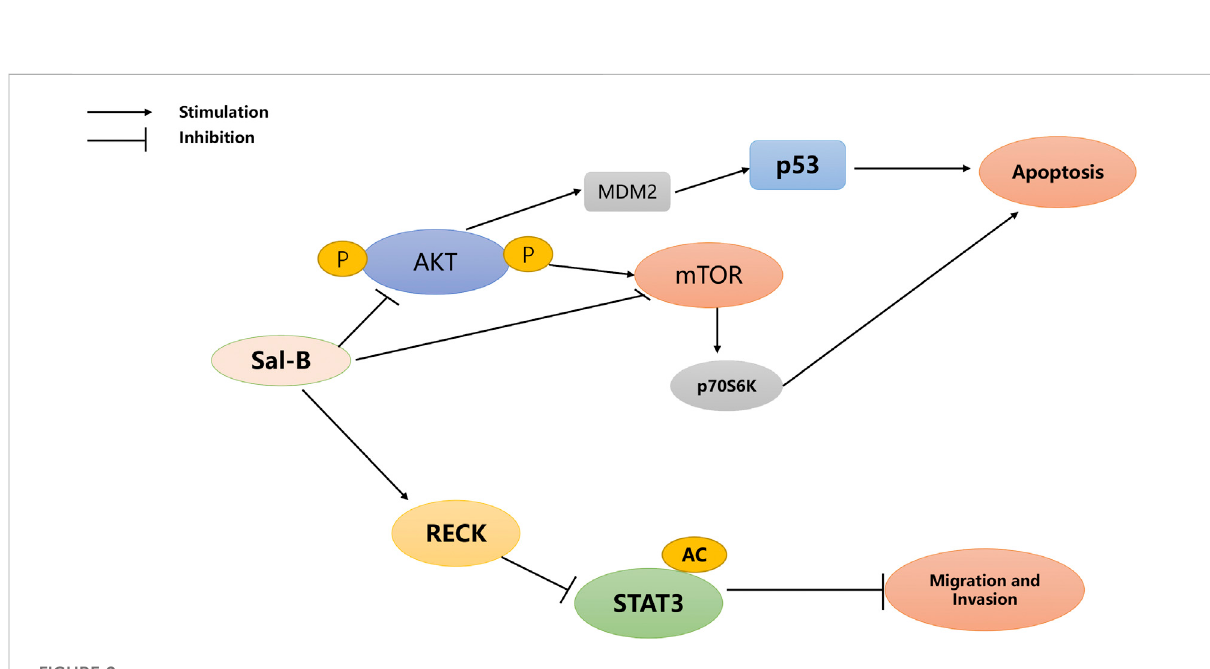
The anti - hepatocellular carcinoma pathway of